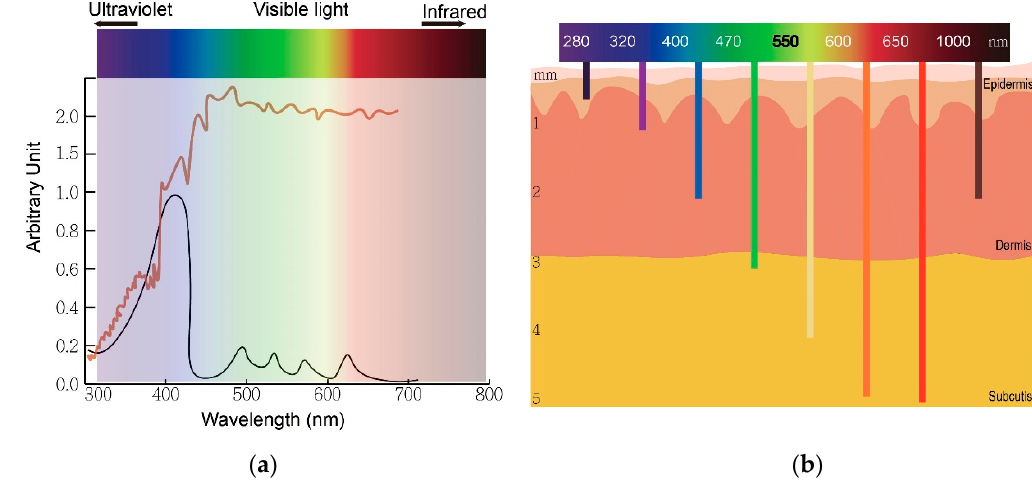
Figure 2. The wavelength of light determines an optimal therapeutic window of photodynamic therapy. ( a ) The absorption peaks of protoporphyrin IX (black) and sunlight spectrum (brown). ( b ) The relationship between wavelengths of light and skin penetration depth.